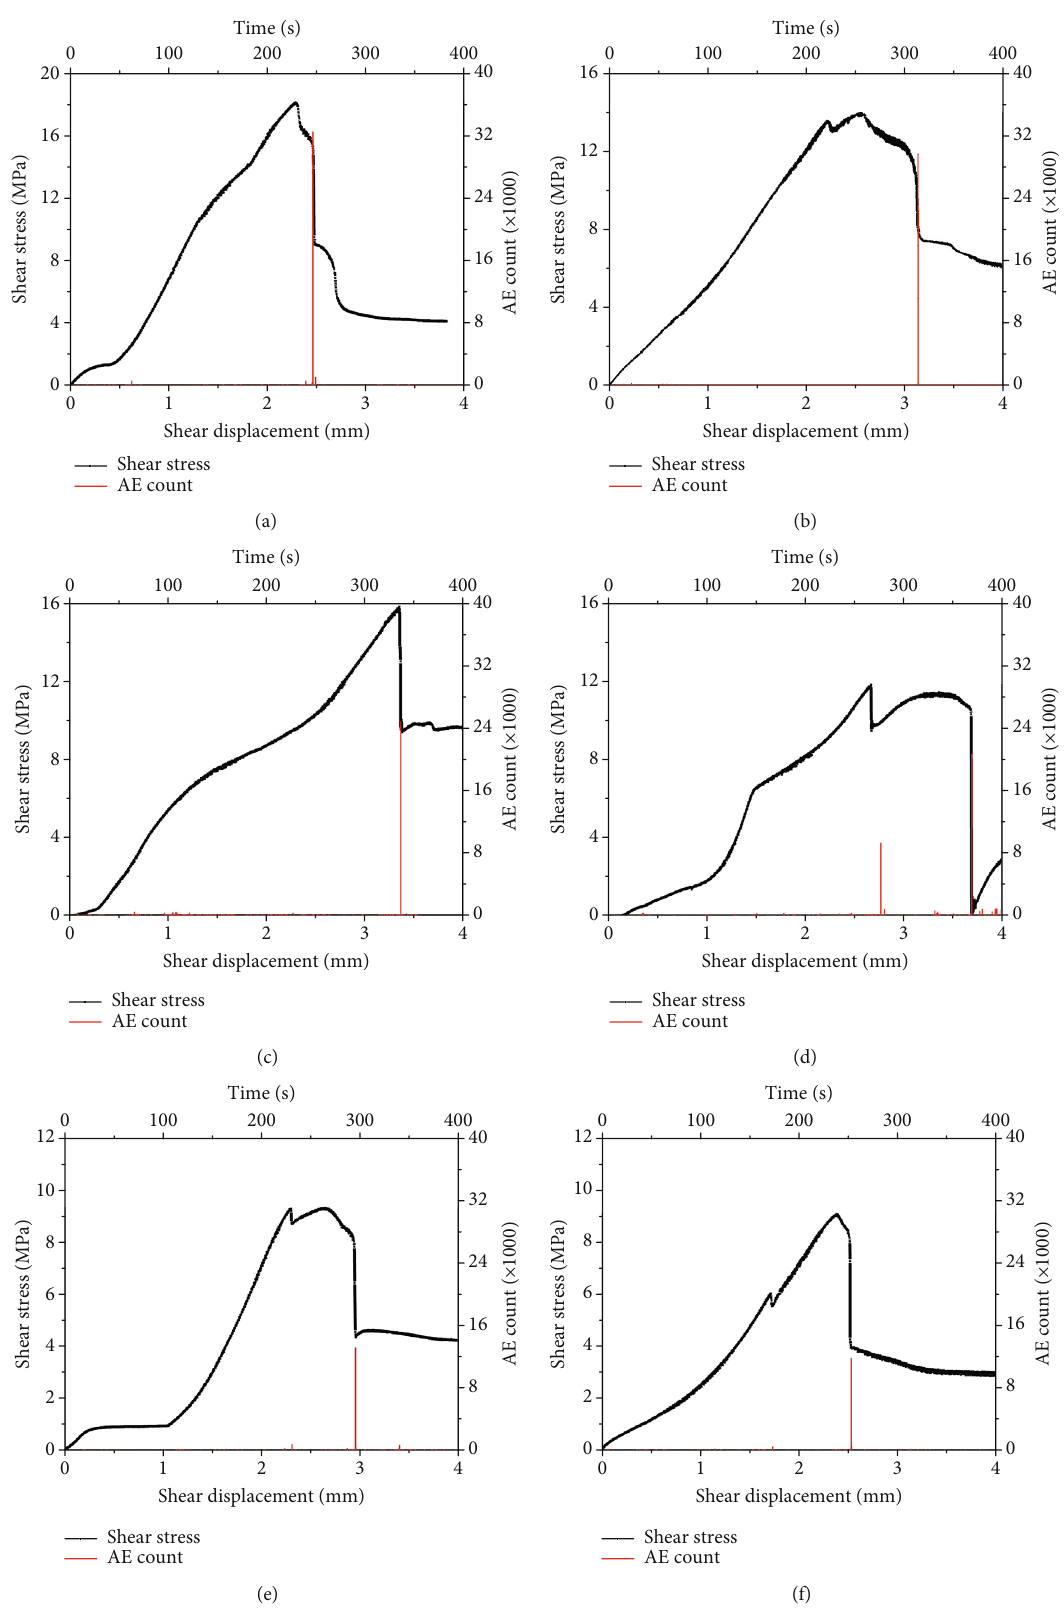
Figure 7: The cumulative AE events and shear stress with shear displacement of specimens with unilateral crack of di ff erent lengths: (a) 0 cm; (b) 2 cm; (c) 4 cm; (d) 6cm; (e) 8cm; (f)